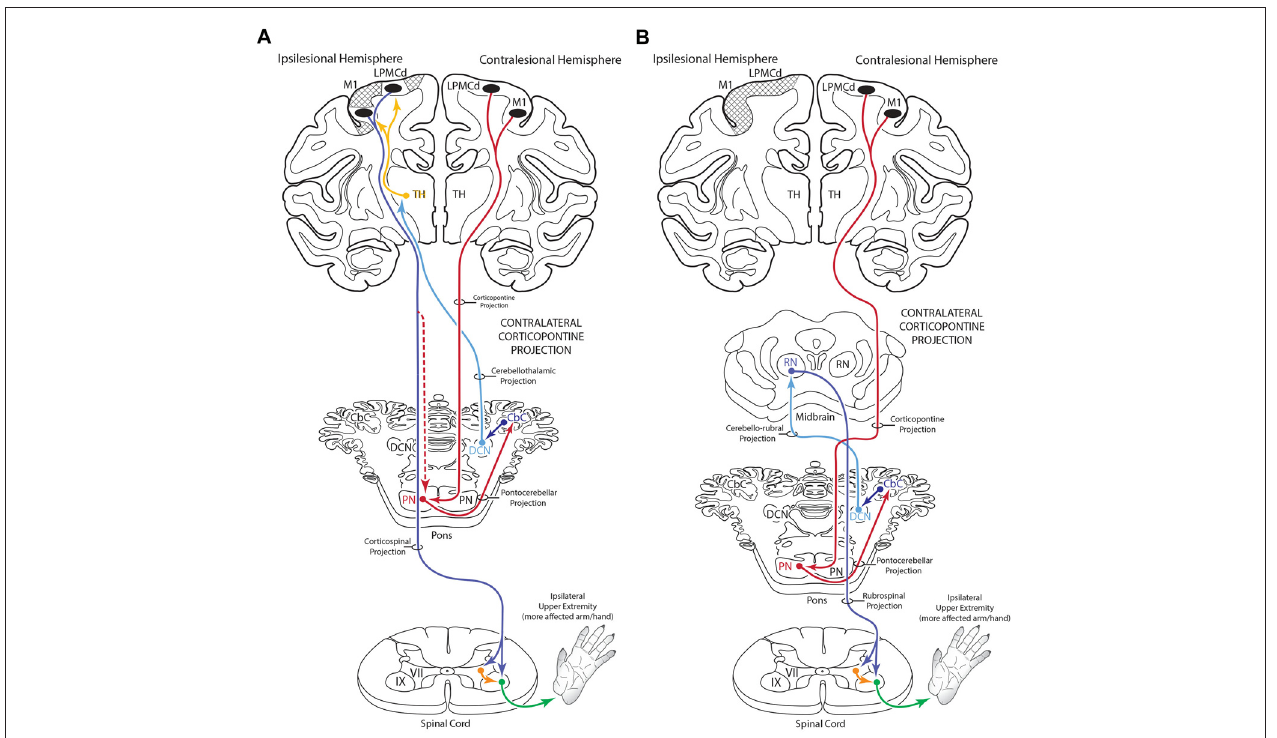
FIGURE 12 | Summary diagram (A) illustrating the potential influence of the cCPP from the non-lesioned hemisphere on the recovery process of the more affected limb following subtotal unilateral motor cortex injury. Following partial motor cortex destruction, a cCPP may augment the effects of the surviving components of the iCPP (red dashed line) originating from the lesioned hemisphere. Also illustrated (B) is the potential parallel contribution of a cCPP to motor recovery of the more affected limb through the rubrospinal projection, particularly following massive unilateral motor cortex injury. In both illustrations the cross hatching represents lesioned